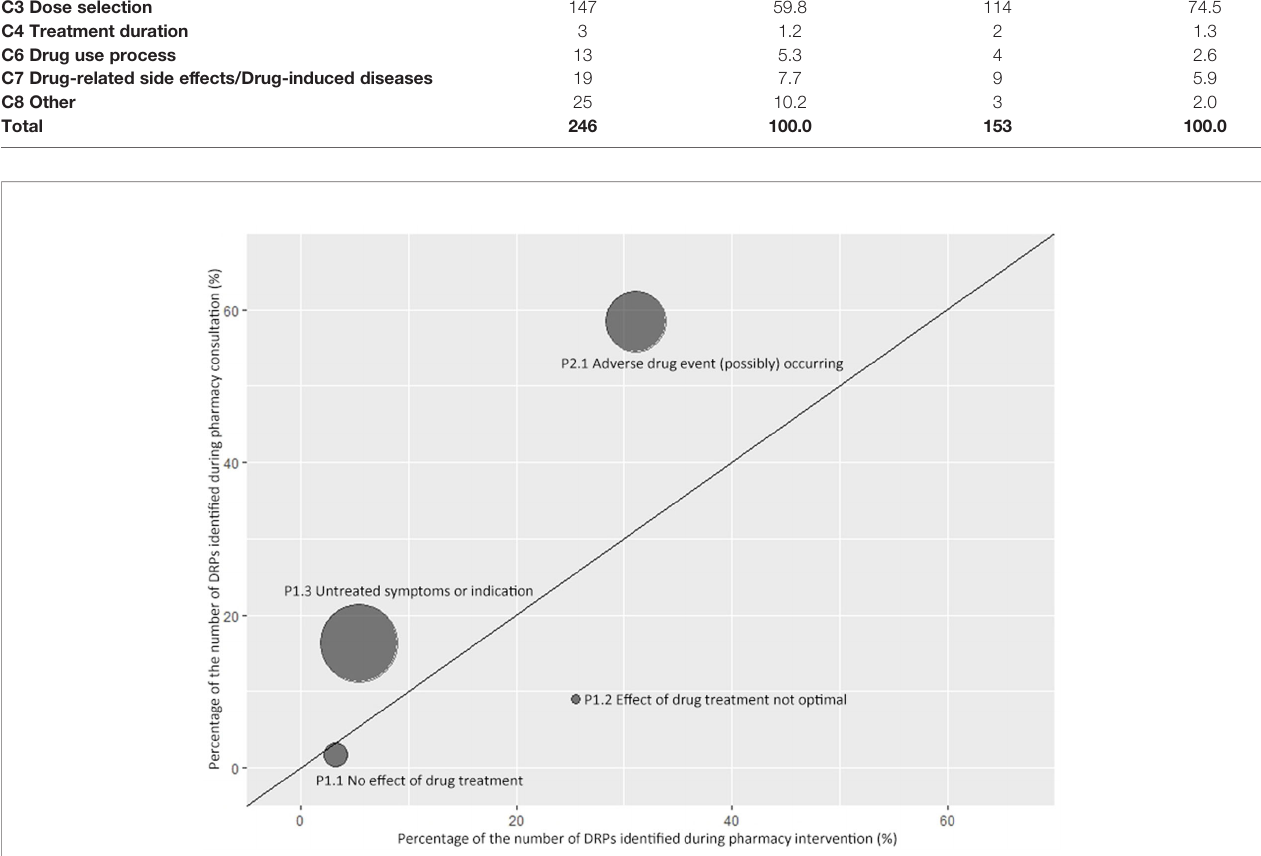
FIGURE 3 | Comparison of drug-related problems identi fi ed during pharmacy consultation and intervention. A symmetrical bubble chart was used to describe the ratio of the proportion of DRPs identi fi ed during pharmacy consultation and intervention. The horizontal axis indicates the proportion of the corresponding Problem in all DRPs identi fi ed during pharmacy intervention. The vertical axis indicates the proportion of the corresponding Problem in all DRPs identi fi ed during pharmacy consultation. The size of the bubble is proportional to the ratio between y and x axes. The oblique line shown in the fi gure is a straight line with a slope of